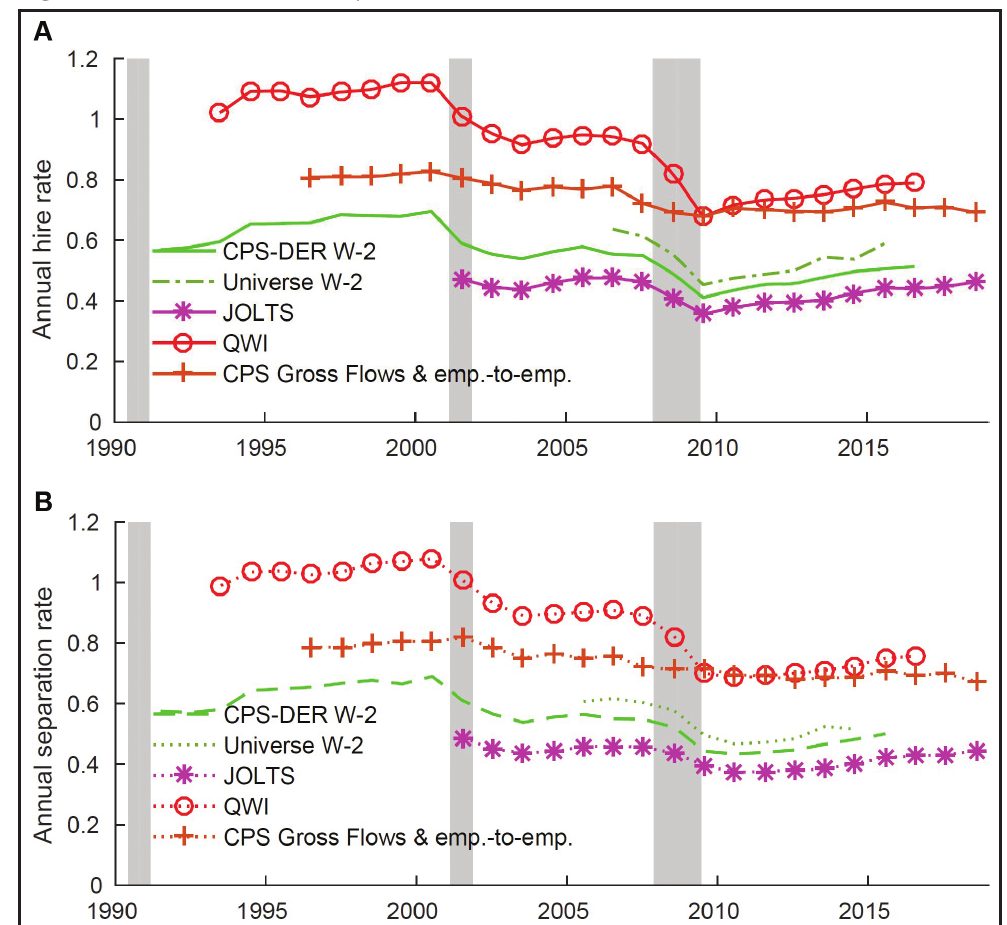
Figure E2 Annual hire and separation